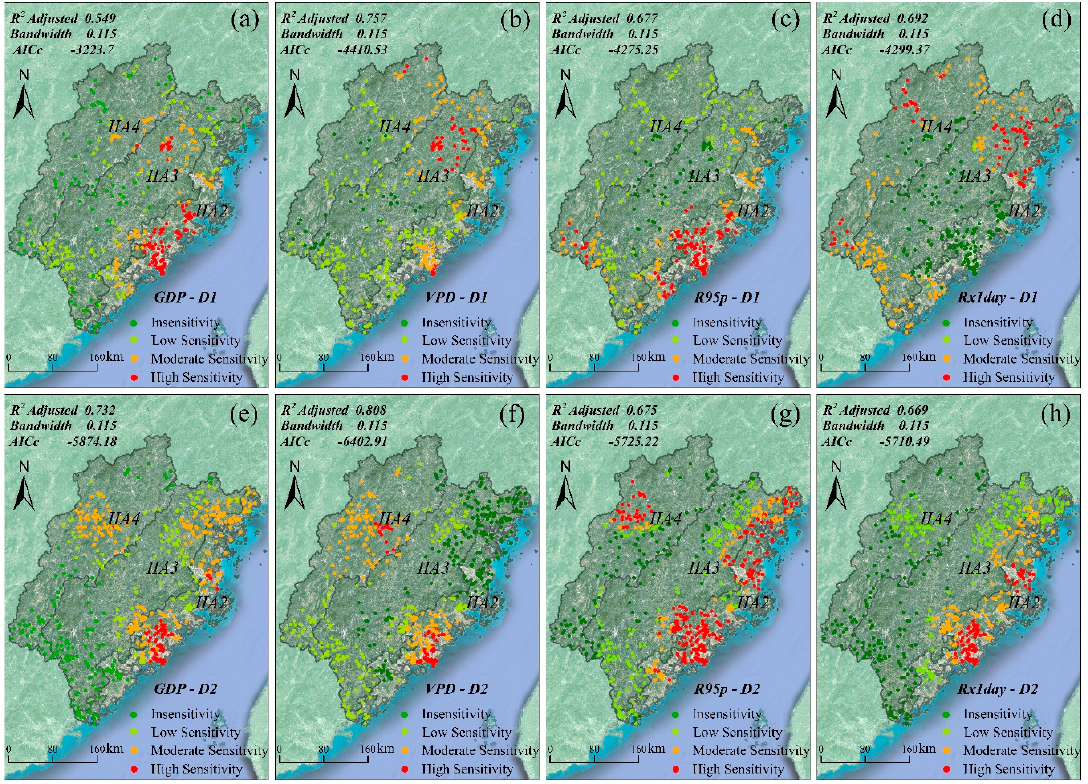
Figure 7. The sensitivity of flash flood to the ( a ) GDP, ( b ) POP, ( c ) R95p, and ( d ) Rx1day in the D1 period and the sensitivity of flash floods to the ( e ) GDP, ( f ) VPD, ( g ) R95p, and ( h ) Rx1day in the D2 period using GTWR.